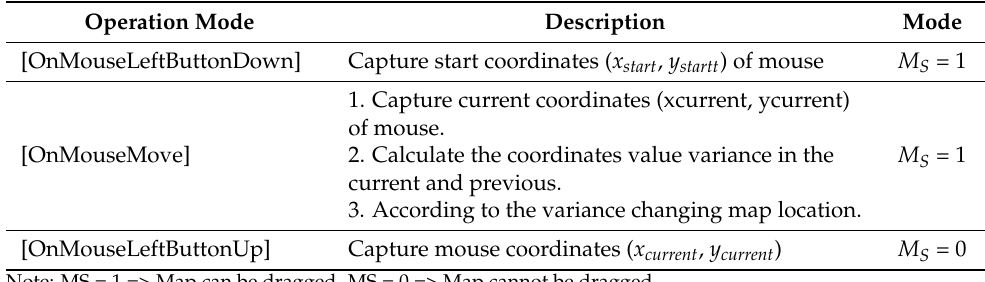
Table 2. Drag and drop by using the mouse.